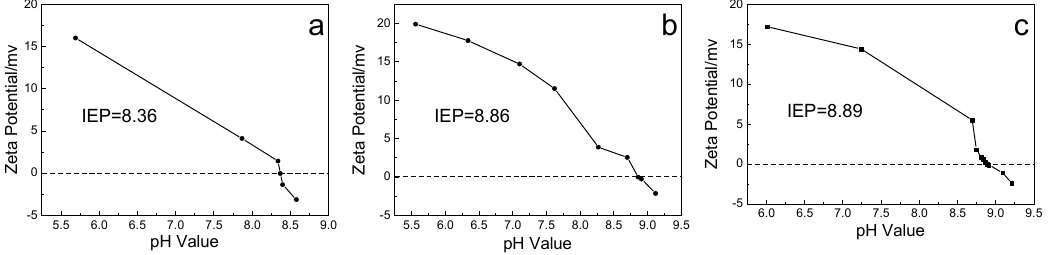
Figure 5. The zeta potential curve of ( a ) GA-1-500, ( b ) GA-2-500, and ( c ) SB-500.